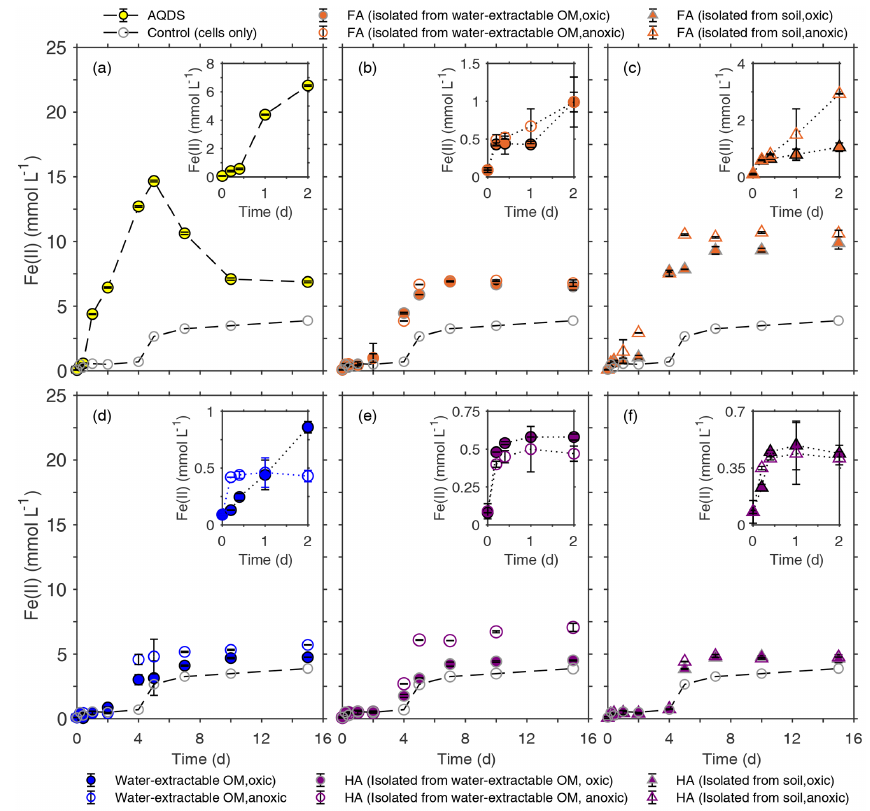
Figure 4. Microbial reduction of ferrihydrite (15mM) by S. oneidensis MR-1 (10 7 cellsmL − 1 ) in the presence of 15mmolL − 1 lactate as electron donor and 50mgCL − 1 FA (b, c) , water-extractable OM (d) , and HA (e, f) compared to 100µmolL − 1 AQDS (a) presented as formation of total Fe(II) over time. The inserts in panels (a) – (f) show the data points for the first 2d of incubation. All experiments were incubated in airtight 100mL glass serum bottles flushed with N 2 at 30 ◦ C in the dark. Control samples were incubated at the same condition in the absence of electron shuttles (ferrihydrite, lactate, and cells only). Error bars represent standard deviations of triplicate